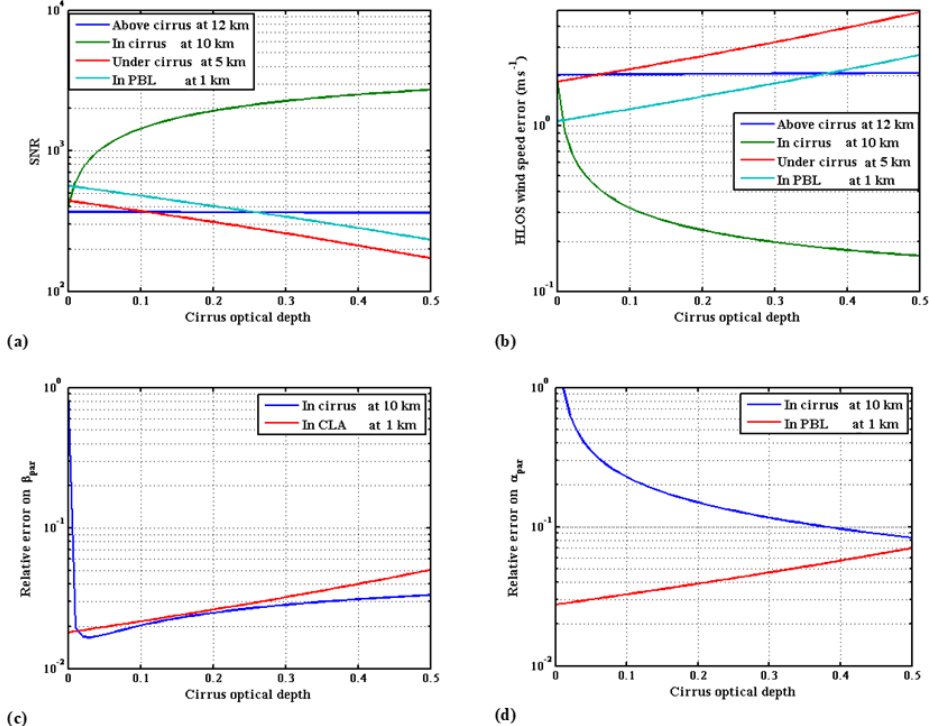
Figure 11. (a) SNR, (b) HLOS wind speed error, (c) β par relative error, and (d) α par relative error as a function of the cirrus vertical optical depth for different measurement